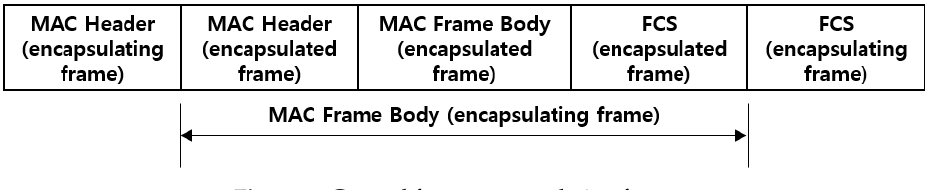
Figure 7. General frame encapsulation format.